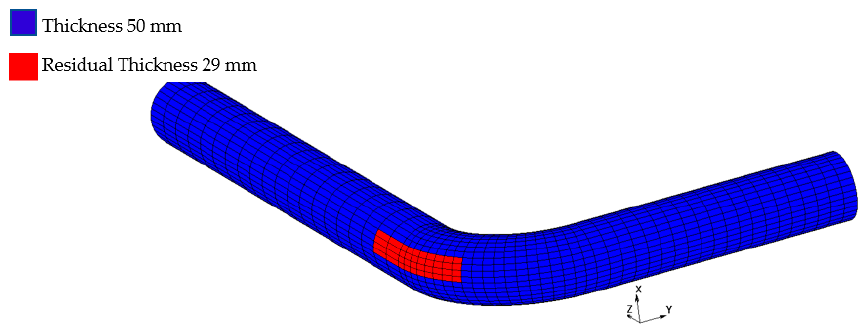
Figure 4. 3D FE model of the bent pipe.